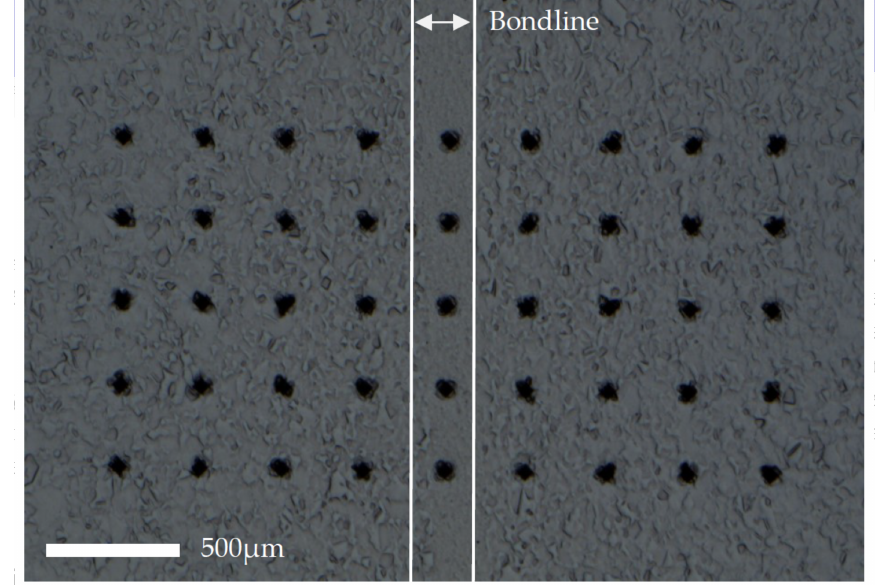
Figure 2. Constructed 9 × 5 grid of Vickers hardness